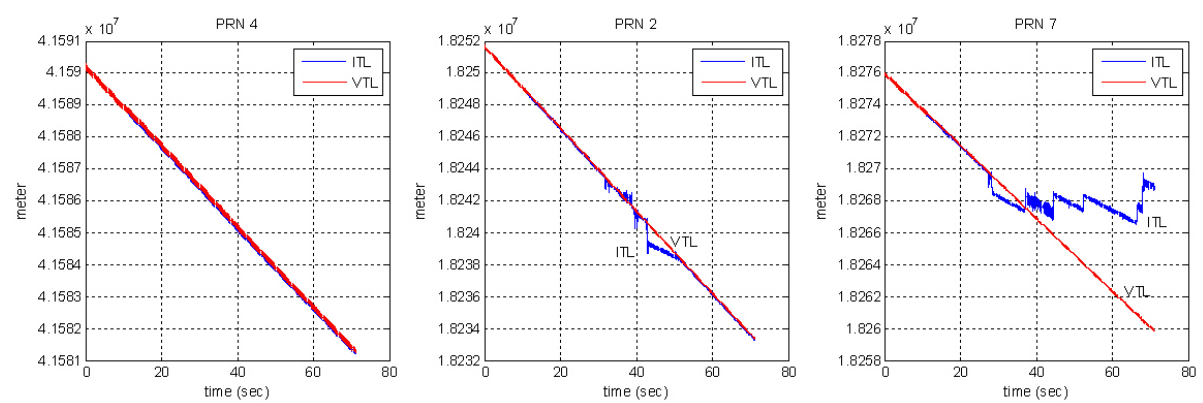
Figure 18. Pseudorange measurements.